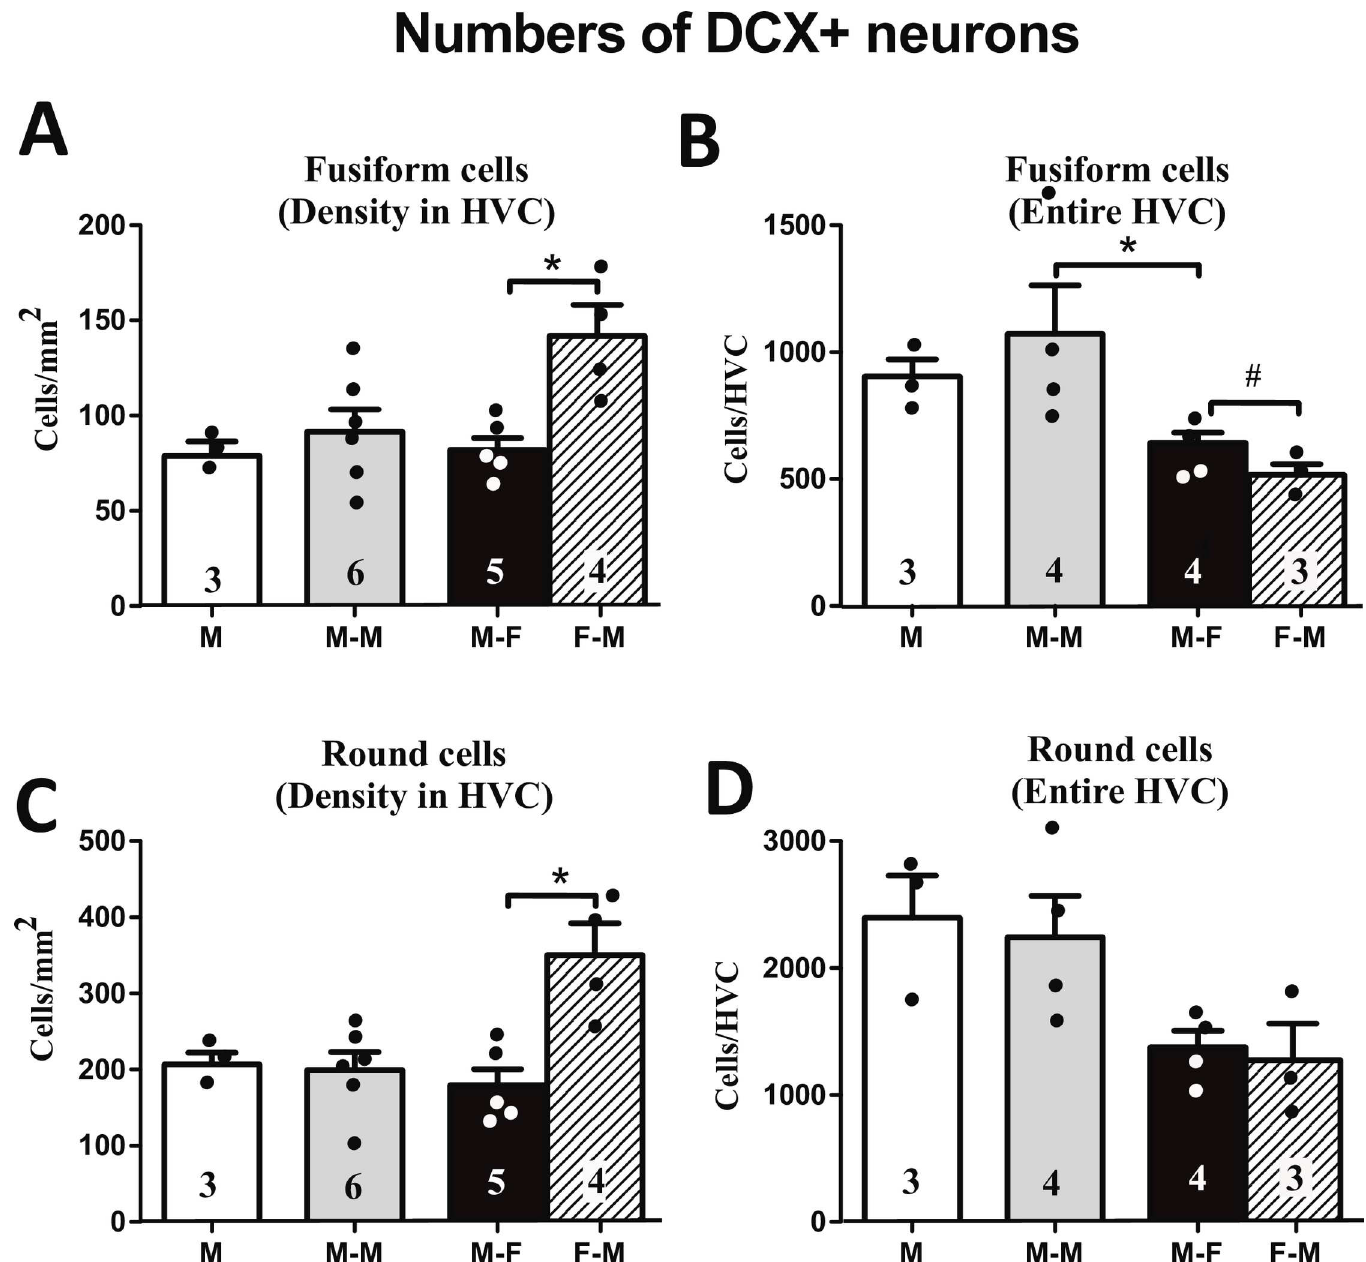
Fig 8. Density of fusiform DCX + (A) and round DCX + neurons (C) in HVC. Numbers of fusiform DCX + neurons (B) or round DCX + neurons (D) estimated for the entire HVC. The figures on the bars indicatethe numbersof availabledata points. * = p < 0.05,# = p <